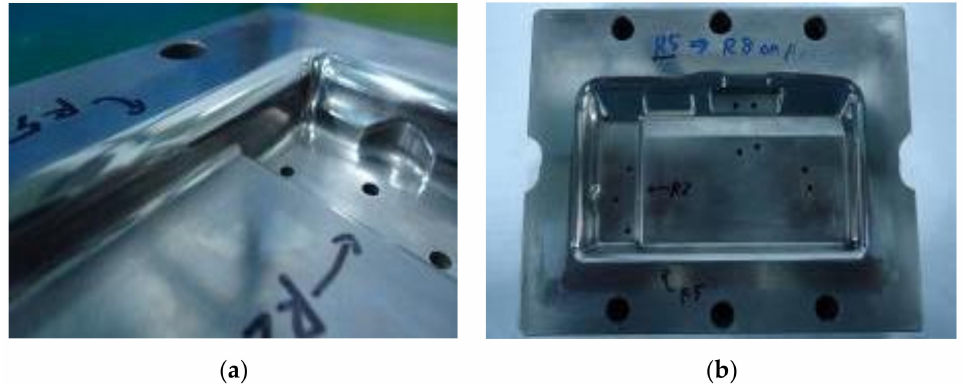
Figure 6. Two cases of the experimental die. ( a ) Case I with R D = 5 mm and R D1 = 2 mm; ( b ) Case II with R D = 8 mm and R D1 = 4